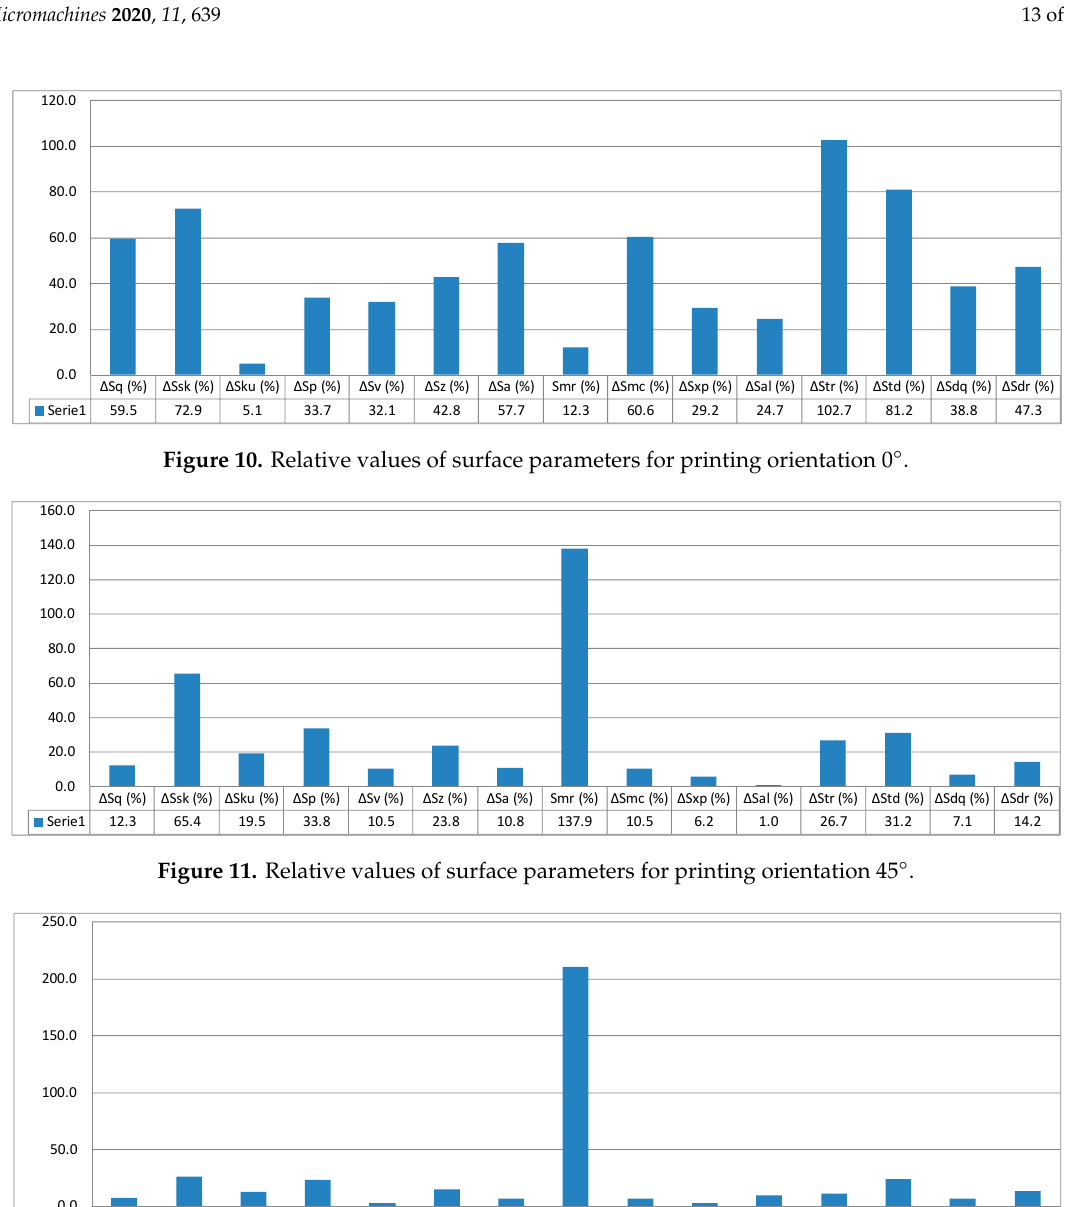
Figure 9. Normal distribution of probability density in the function of the obtained results: ( a ) height of Rms surface— Sq , ( b ) mean arithmetic surface height— Sa , ( c ) orientation of surface height— Std , and ( d ) developed ratio of surface interphasic area— Sd .